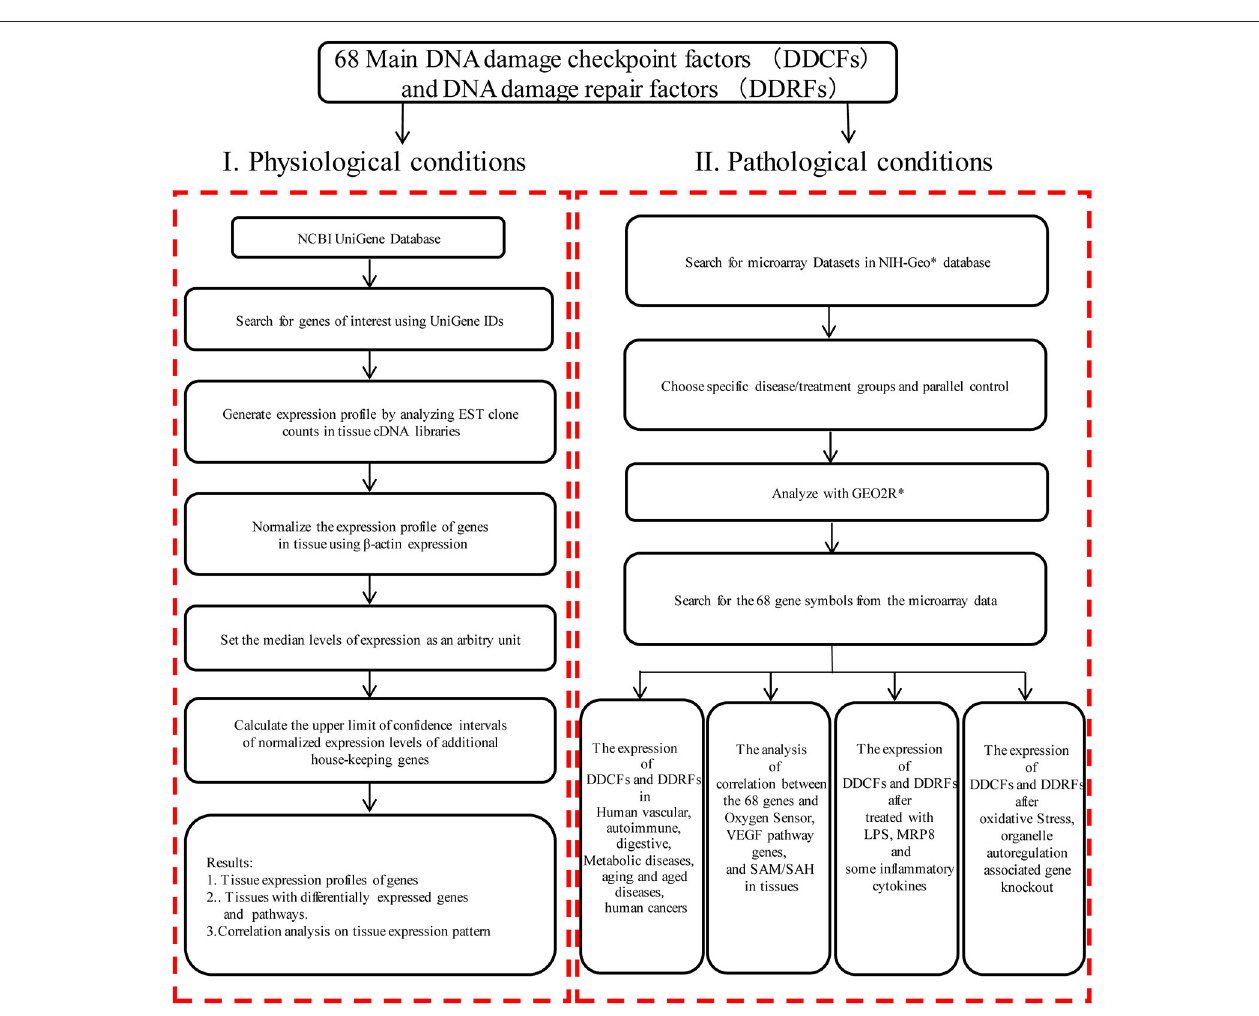
FIGURE 1 | Flow chart of database mining strategy and two parts of data organization. (I) Database mining strategy was used to generate tissue expression profiles of genes in physiological condition. DDCFs, DNA damage checkpoint factors; DDRFs, DNA damage repair factors; NCBI, National Center of Biotechnology Information; IDs, gene identifications; EST, Expressed sequence tag; VEGF, Vascular endothelial growth factor; SAM, S-adenosylmethionine; SAH:S-adenosylhomocysteine. (II) DNA damage checkpoint and repair factors expression changes were analyzed with experimental data from the microarray datasets in diseases, after treated with LPS, MRP8, some inflammatory cytokines, and after oxidative stress, organelle autoregulation associated gene knockout. *NIH-Geo website: www.ncbi.nlm.nih.gov/geo/; GEO2R website: www.ncbi.nlm.nih.gov/geo/geo2r/.